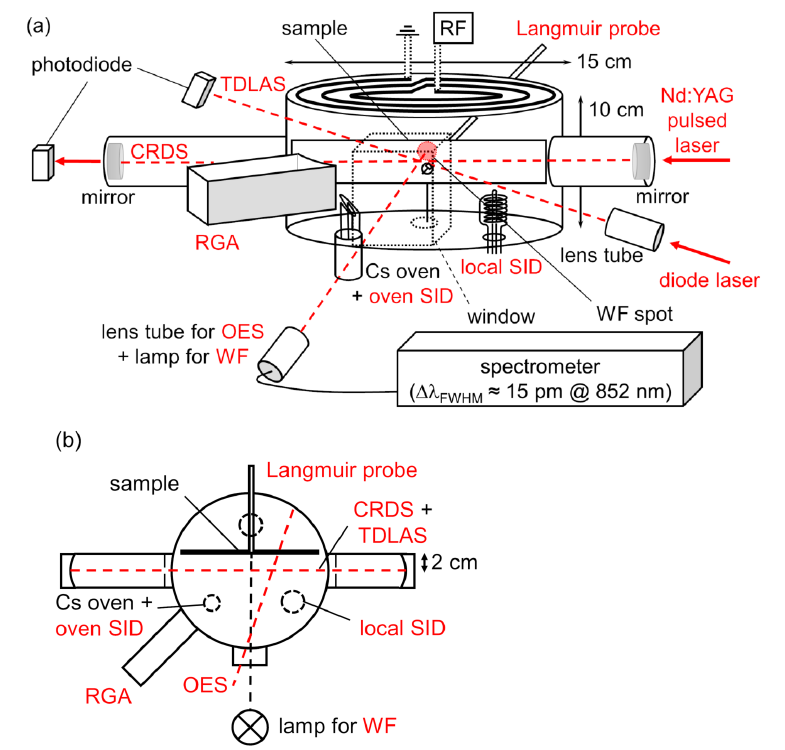
Figure 2. ( a ) Isometric sketch and ( b ) top view of the inductively coupled plasma (ICP) experiment ACCesS with an overview of the different diagnostics applied during the current